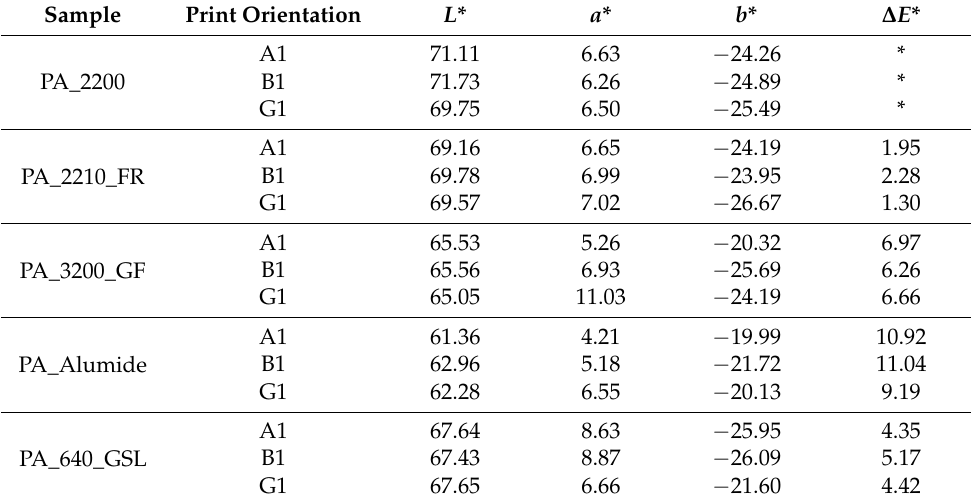
Table 5. Results for color measurement, STD up to